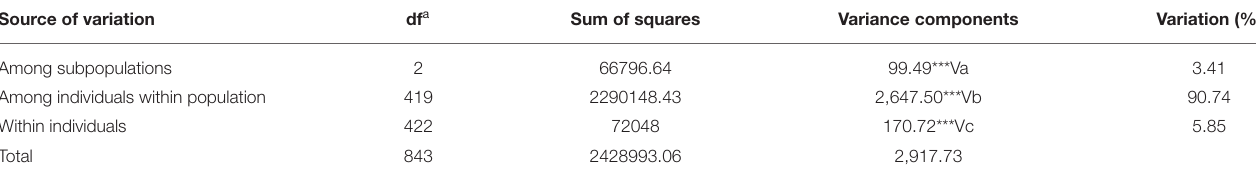
TABLE 4 | Pairwise fixation index (F ST ) between subpopulations SYN-DER ( n = 145), PC ( n = 128), and AL (n = 149).